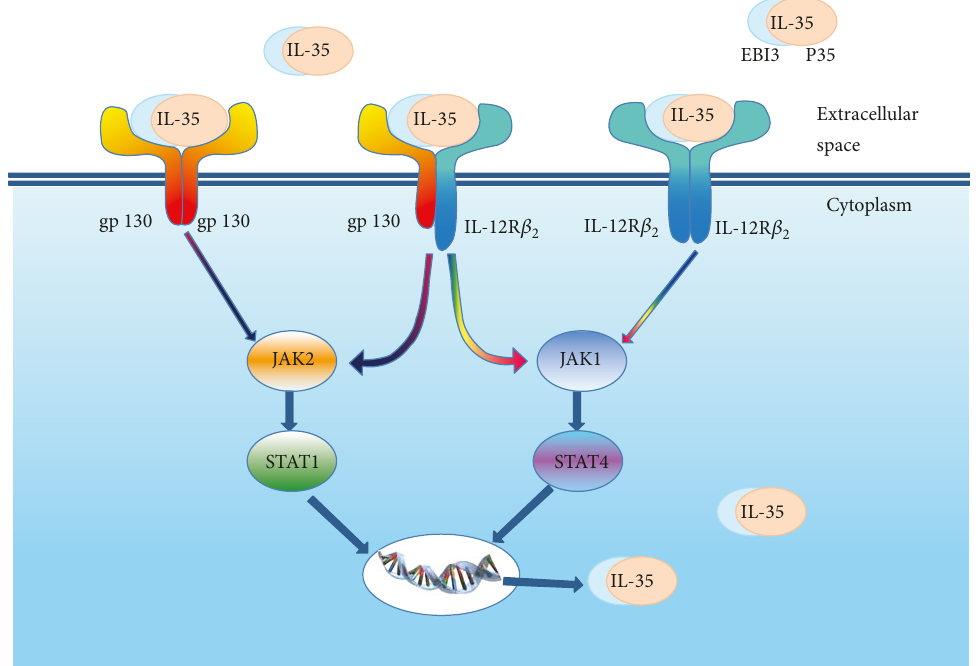
Figure 1: The structure of IL-35 and the activation of the JAK-STAT signaling